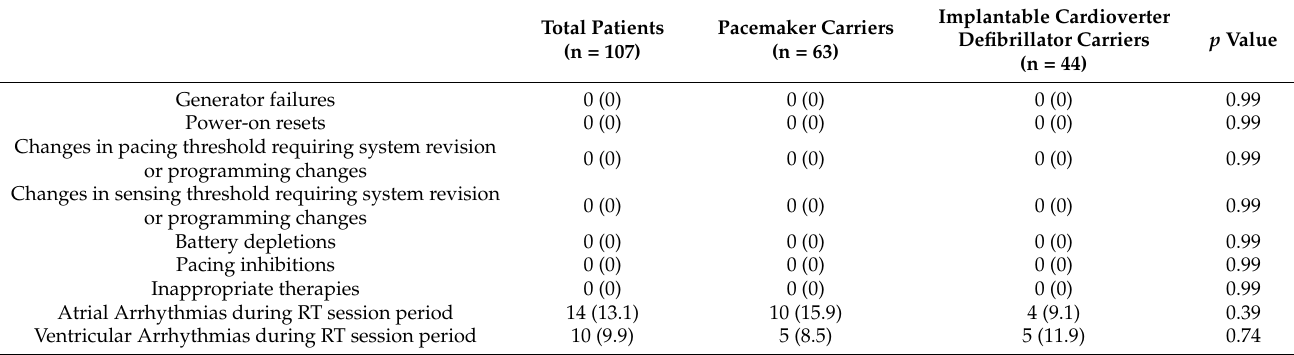
Table 4. Post-radiotherapy